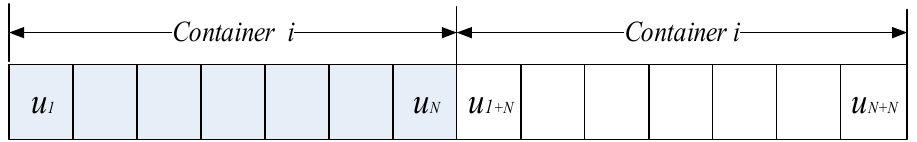
Figure 7. The encoding scheme of position.